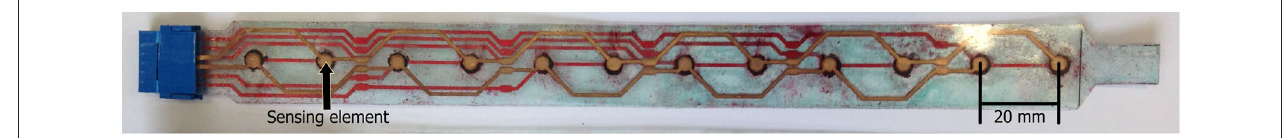
FIGURE 1 | Low-cost, flexible pressure sensor strip containing 12 sensing elements.